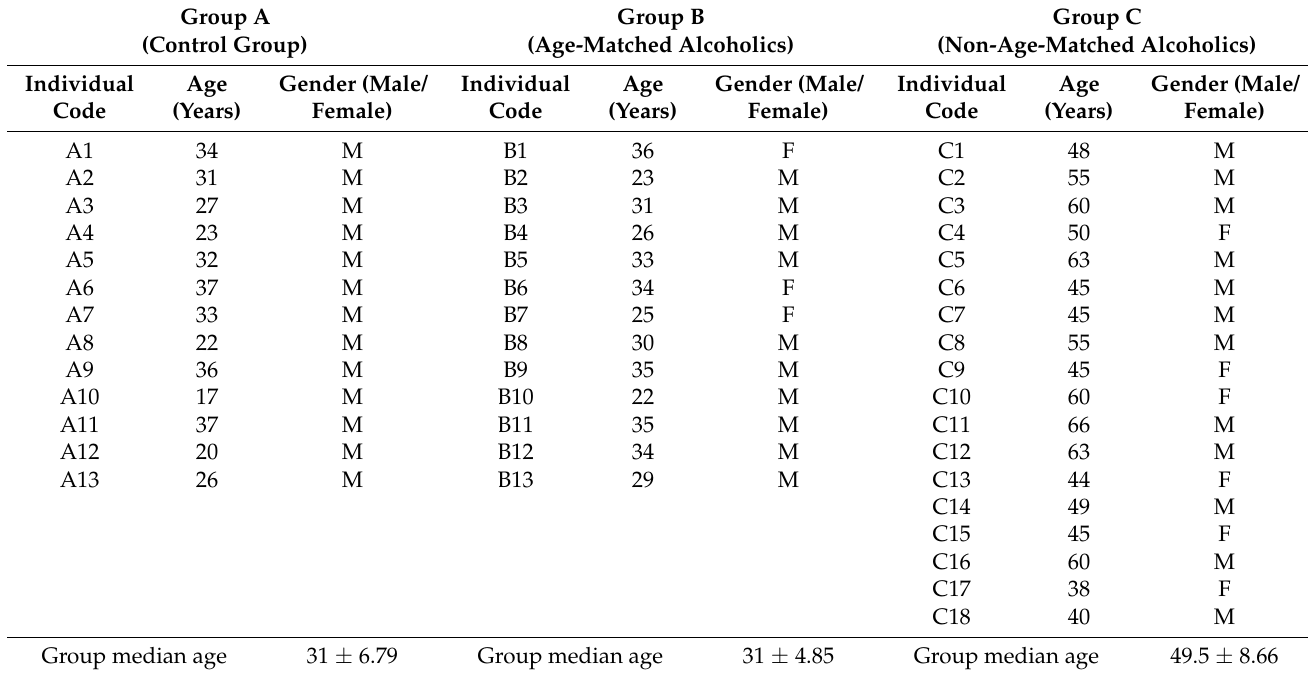
Table 1. Grouping of individuals along with their age and